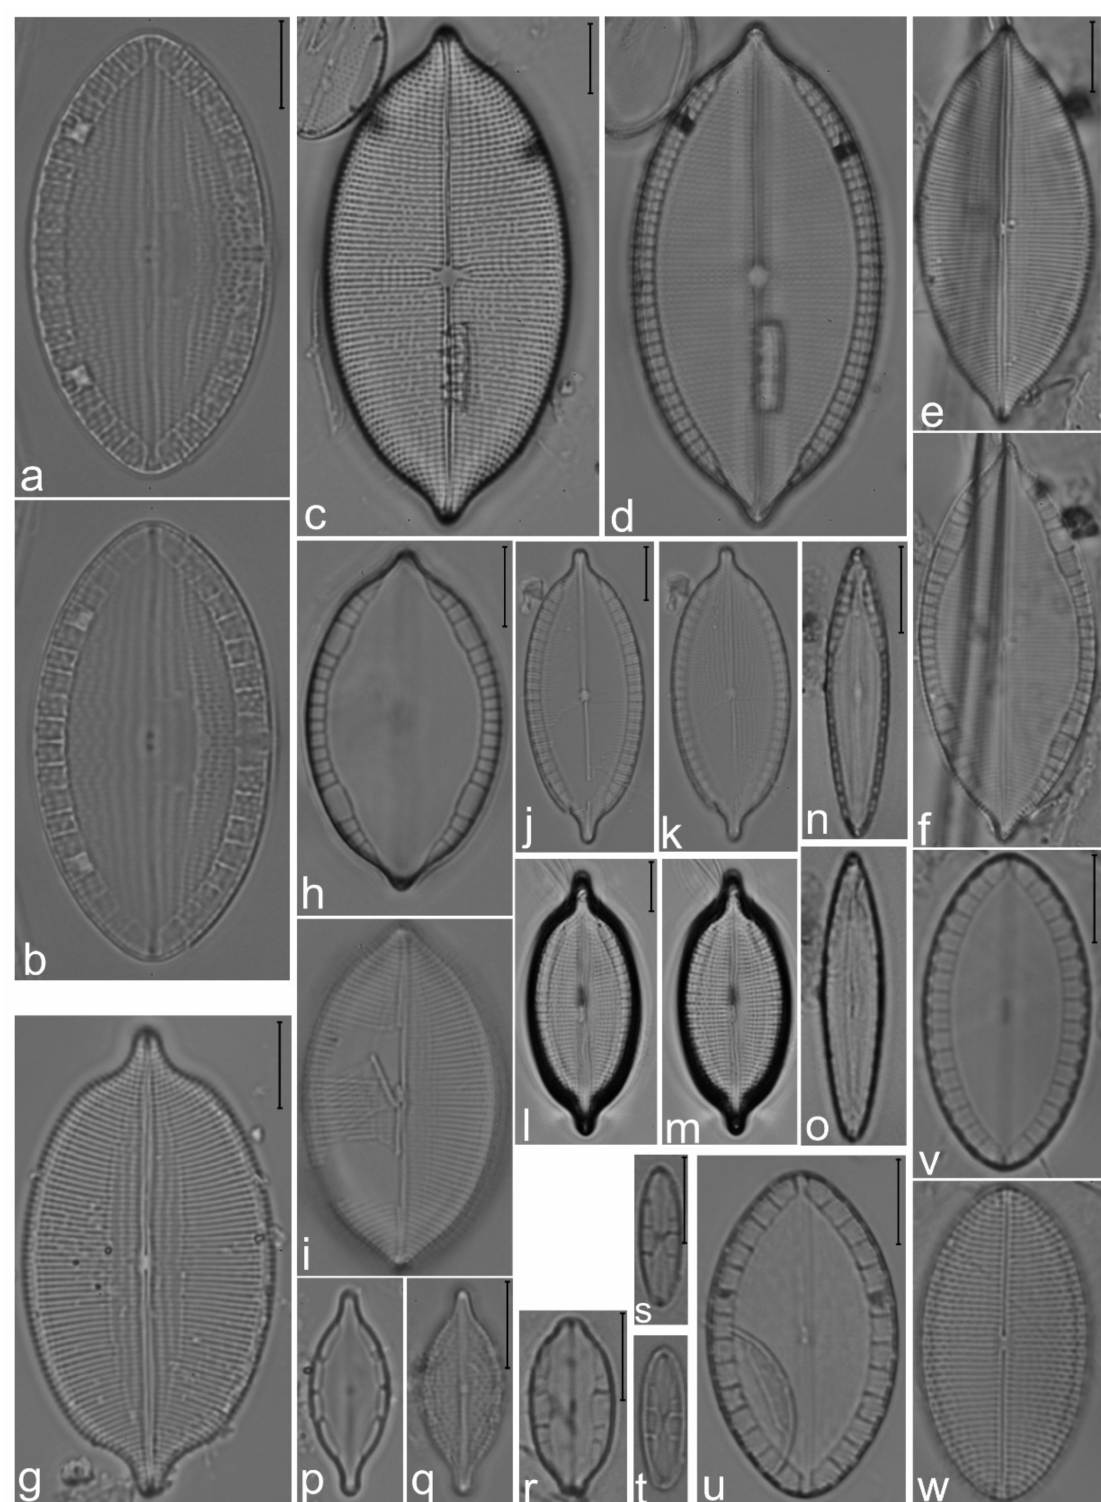
Figure 20. ( a , b , u ) Mastogloia ovata ; ( c , d ) M . pseudoelegans ; ( e – g ) M . mauritiana var. capitata ; ( h , i ) M . mauritiana var. mauritiana ; ( j , k ) M . ignorata ; ( l , m ) M . corsicana ; ( n , o ) M . cuneata ; ( p , q ) M . varians ; ( r ) M . pusilla var. subcapitata ; ( s , t ) M . urveae ; ( v , w ) M . pseudolatecostata . Scale bar = 10 µ